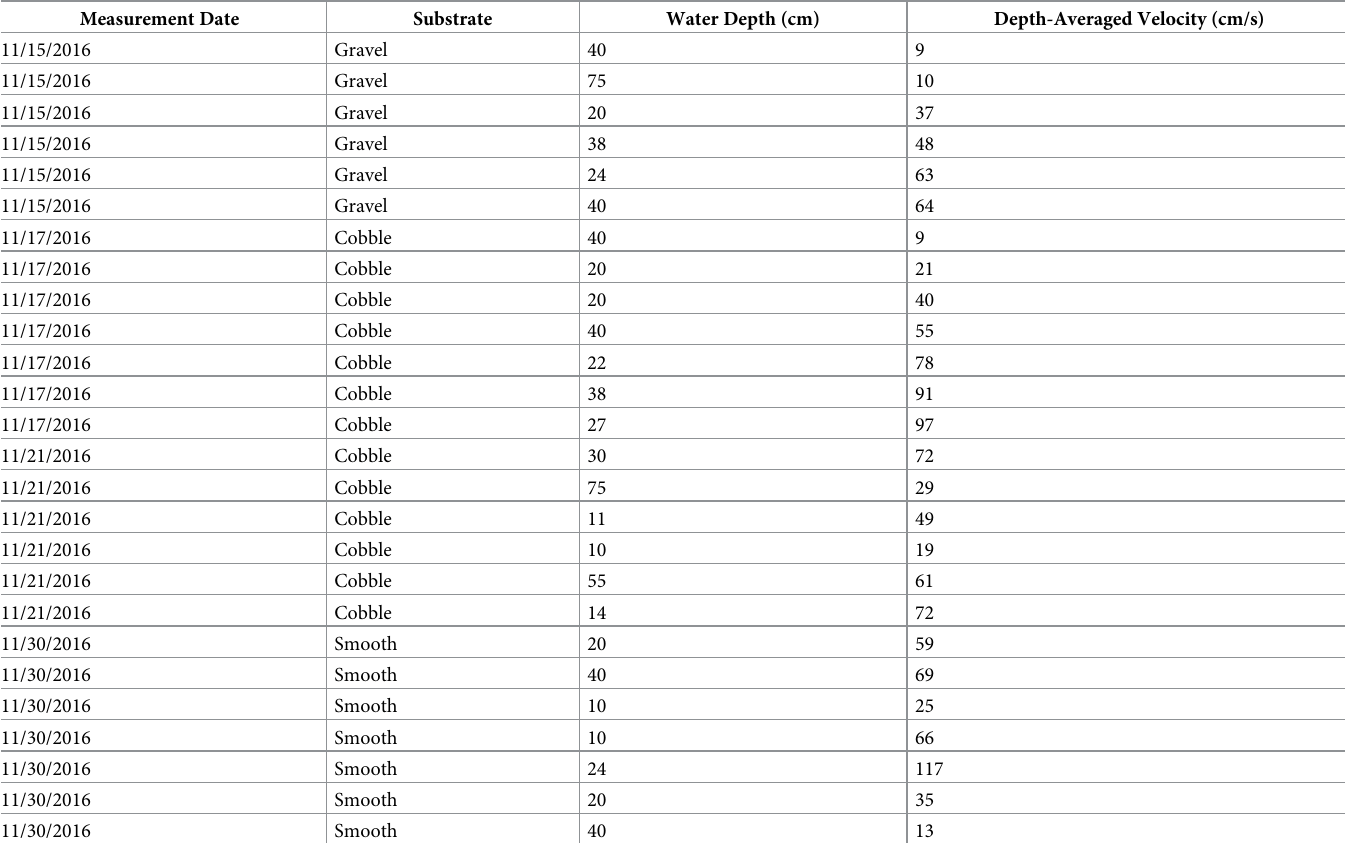
Table 1. Flume test